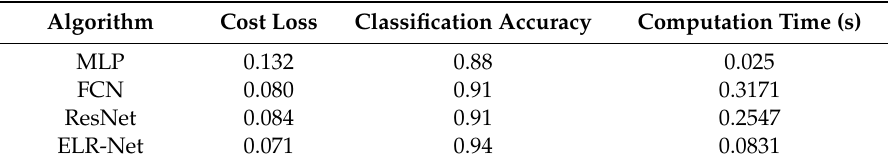
Table 2. Performance comparison of multilayer perceptron (MLP), fully convolutional networks (FCN), ResNet, and ELR-Net, when β =